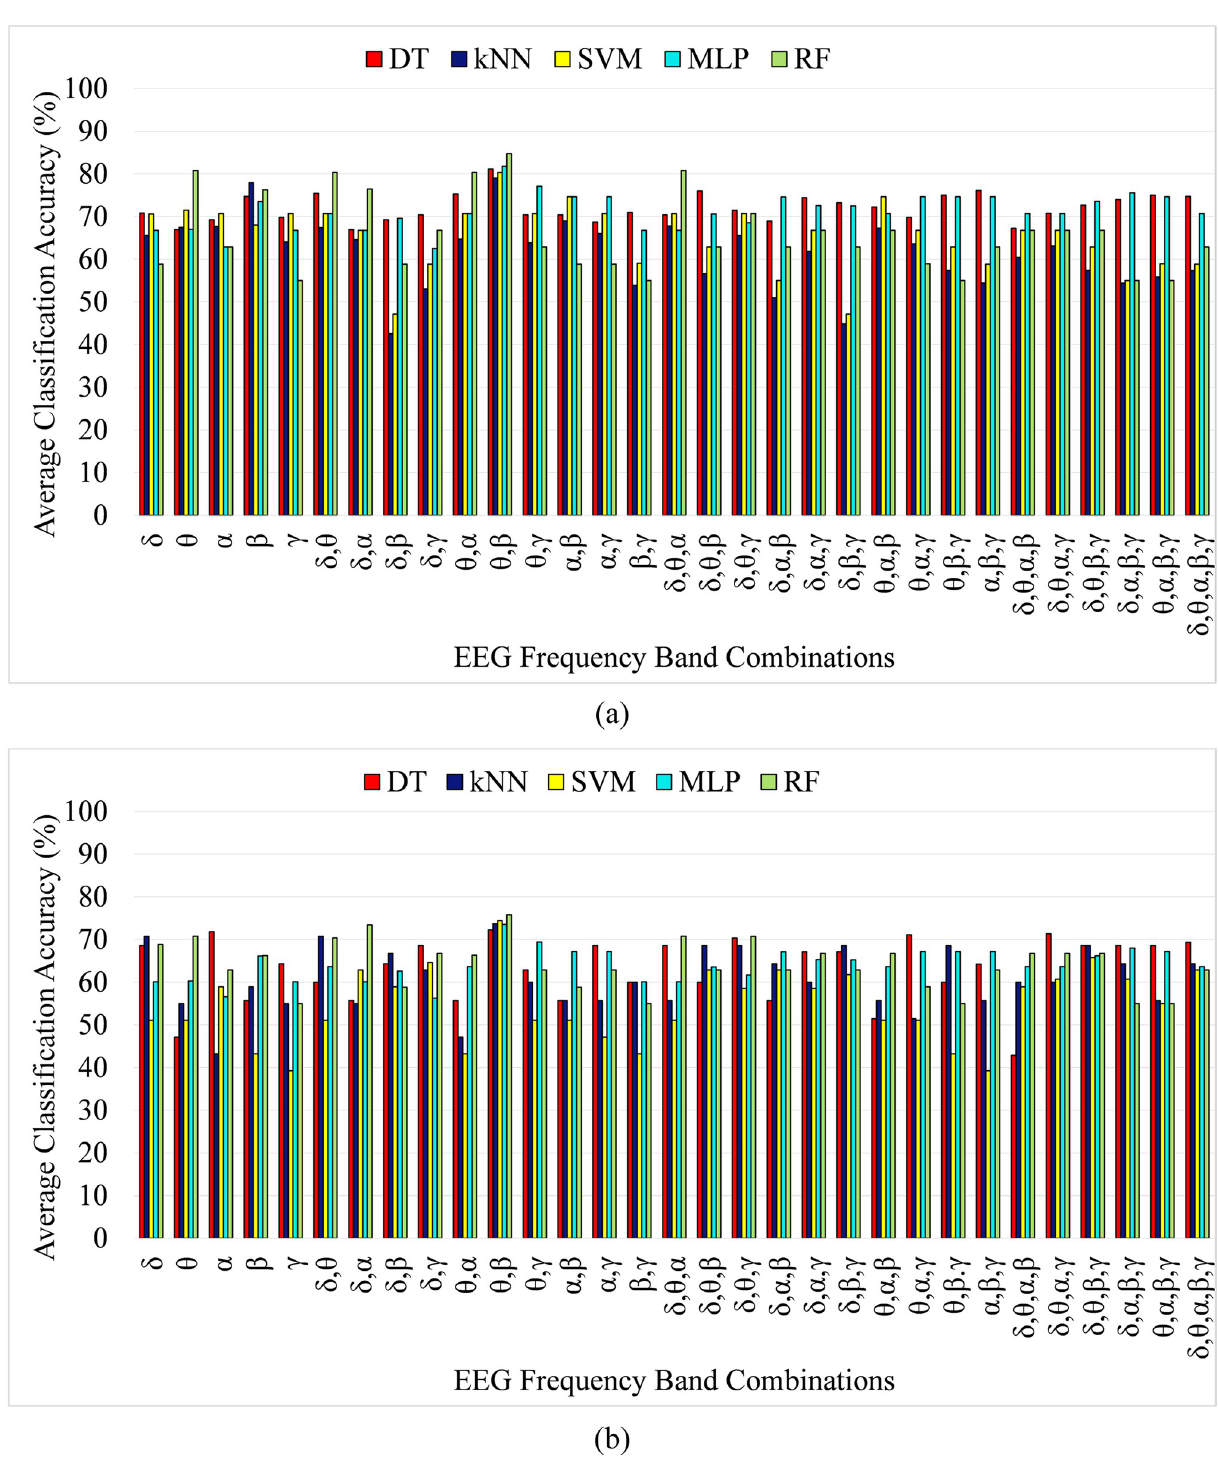
Fig 7. Classification accuracy of DT, k-NN, SVM, MLP and RF classifier using features from different frequency band combinations of EEG signal using SAM score based labeling for (a) Two-levels (b) Four-levels anxiety classification.